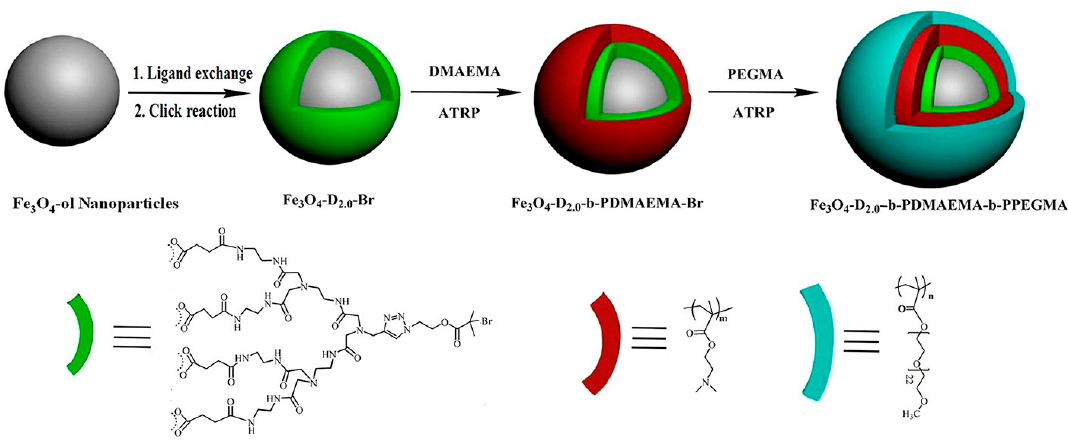
Figure 5. Surface Modification Process of Superparamagnetic Fe 3 O 4 Nanoparticles. Adapted from ref. [46].